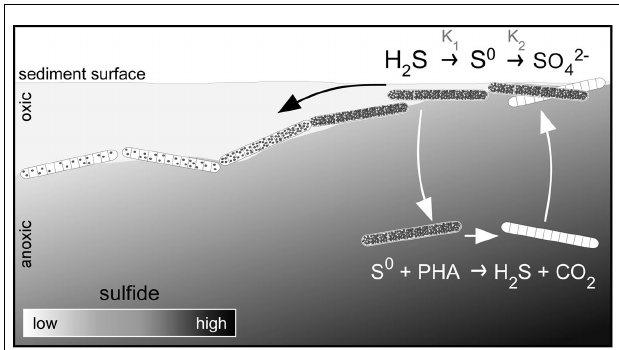
FIGURE 4 | Proposed function of sulfur reduction as a survival strategy of Beggiatoa spp. under high sulfide fluxes. In locations with high sulfide fluxes (right side) filaments become excessively filled with sulfur (black dots inside the filaments), because the oxidation rates of sulfide to sulfur ( K 1 ) and sulfur to sulfate ( K 2 ) are not well balanced ( K 1 > K 2 ).To prevent bursting, the filaments could move into a region with a lower sulfide flux (black arrow) where these two reactions may proceed in a balanced way. If this is not possible, filaments could leave the oxygen–sulfide interface and move down into the anoxic region to reduce their internal sulfur deposits and thus prevent bursting (white arrow).They do so by using internally stored PHA as an electron donor to reduce S 0 to H 2 S. After emptying storage space, the filaments return to the oxygen–sulfide interface, and continue with aerobic sulfide